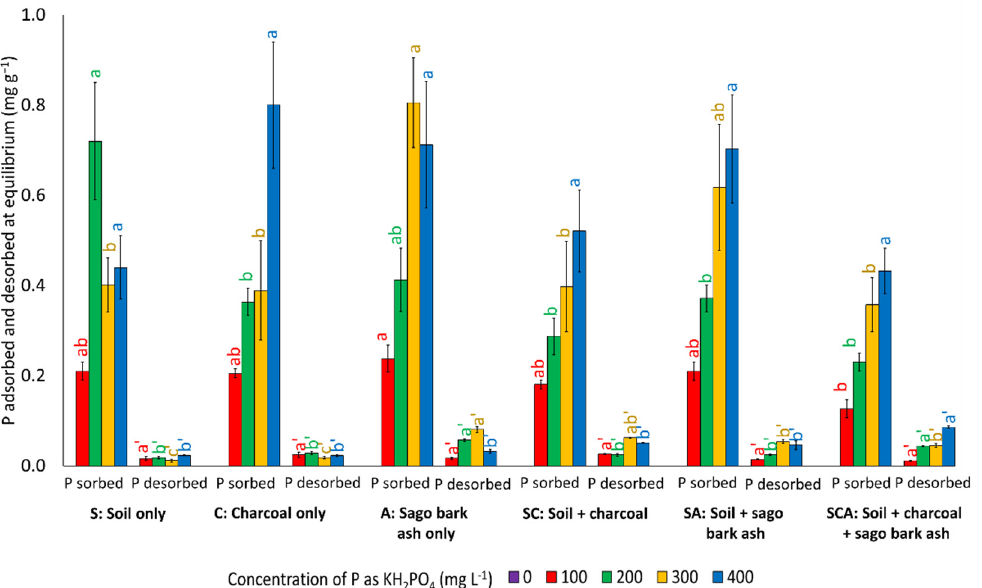
Figure 4. Summary of the amounts of phosphorus adsorbed and desorbed at different potassium dihydrogen phosphate concentration as affected by soil alone, amendments alone, and soil with the amendments. Means with different letter(s) within the same font colour indicate significant differences between treatments according to Tukey’s HSD test at p ≤ 0.05, i.e., a > b > c. Bars represent the mean values ± SE.